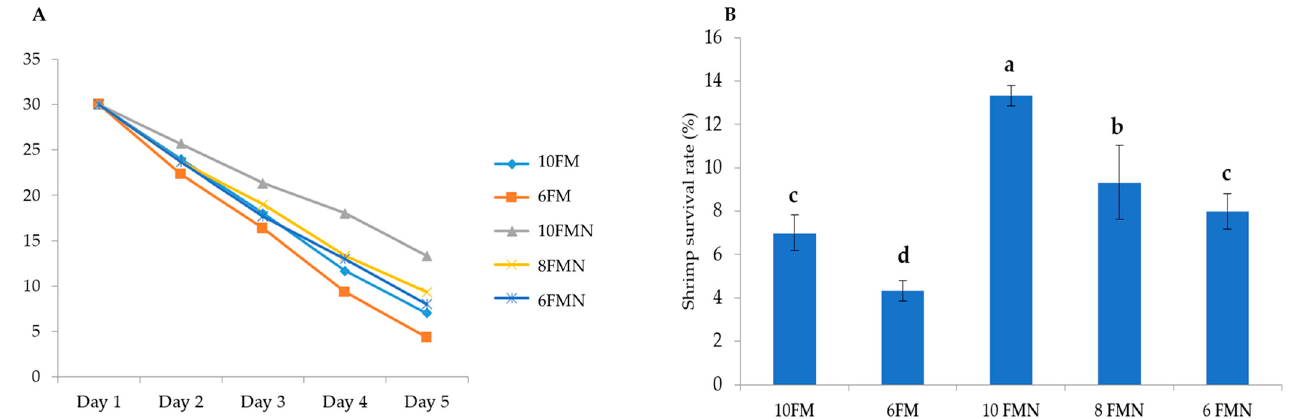
Figure 5. ( A ) Evolution of mean survival rate in Pacific white shrimp (PWS) over time in each study group after challenge test with Vibrio harveyi infection at dose of 1 × 10 5 CFU mL − 1 , intramuscularly; ( B ) mean survival rate at the end of the challenge test. Different letters indicate statistically significant differences ( p < 0.05) between the study groups. 10FM (control group; 10% FM), 6FM (6% FM and no nucleotide supplementation), 10FMN (10% FM; 0.1% nucleotides), 8FMN (8% FM; 0.1% nucleotides) and 6FMN (6% FM; 0.1% nucleotides).